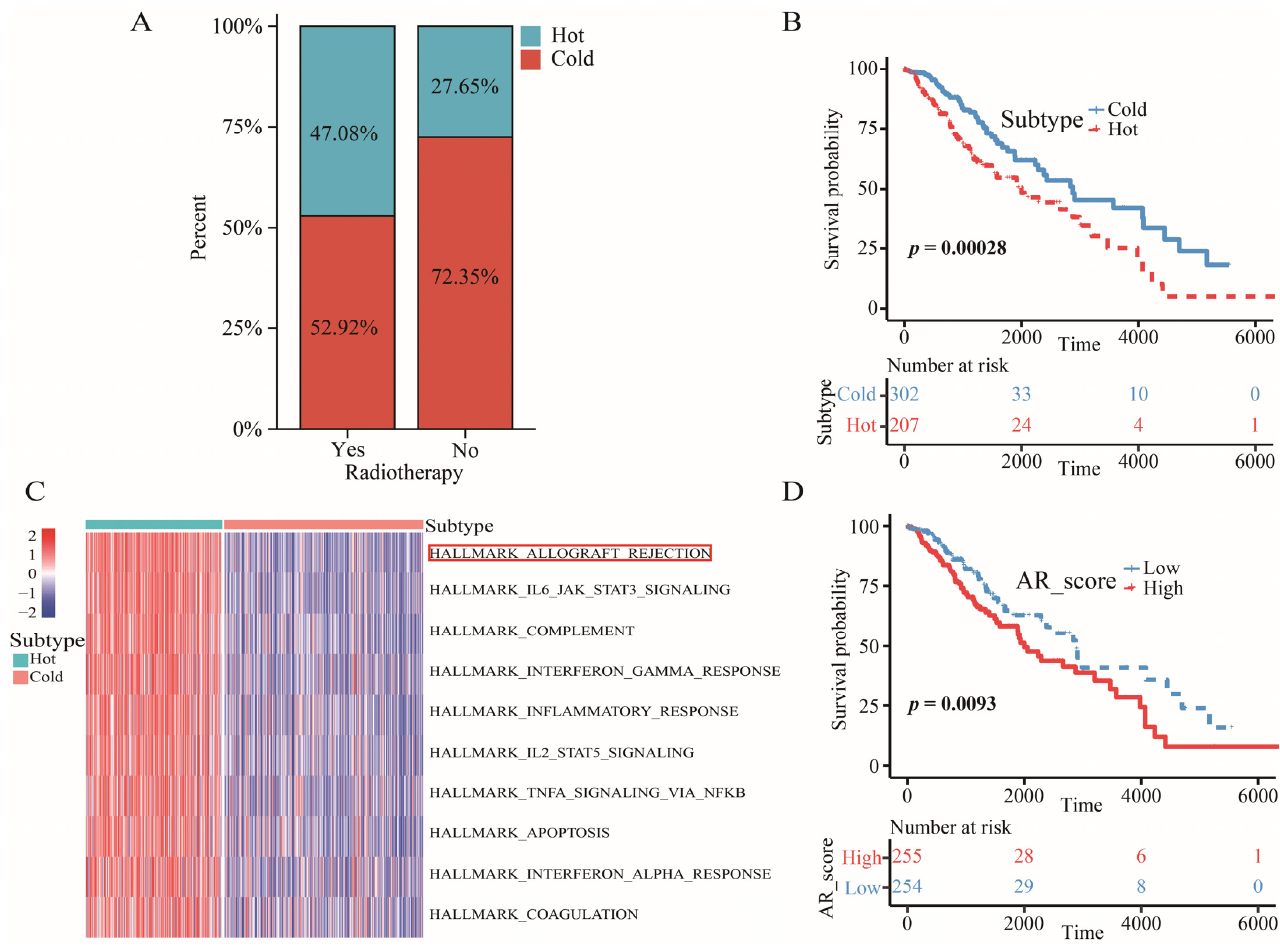
Figure 2. The characteristic of “hot” tumors, “cold” tumors, and AR signaling pathway. ( A ) The distribution of “hot” and “cold” tumors in patients with or without radiotherapy. ( B ) Kaplan–Meier survival analysis of OS between “hot” and “cold” tumors. ( C ) GSVA analysis of 50 hallmark pathways between cluster 1 and cluster 2. ( D ) Kaplan–Meier survival analysis of OS between high- and low-AR_score groups.